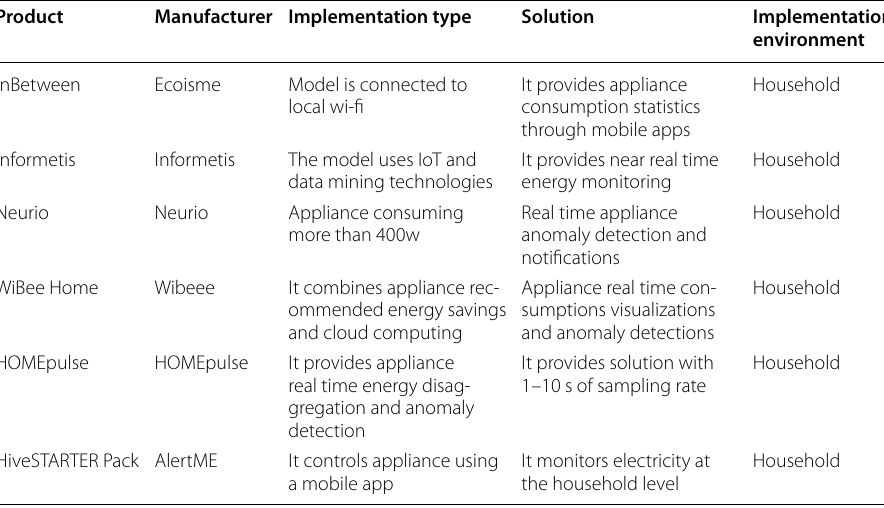
Table 7 Anomaly detection solution for households